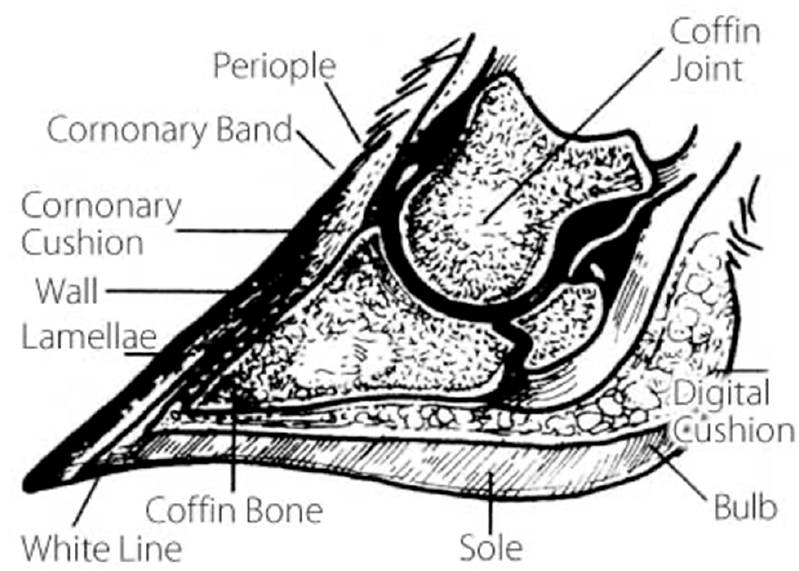
Figure 1. Cross section of bovine foot [3], courtesy of Zinpro